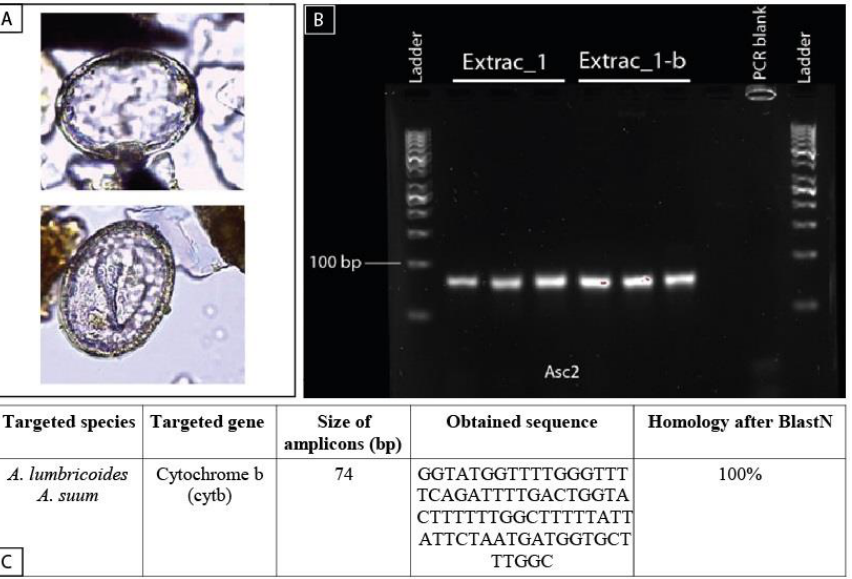
Figure 3. ( A ) Ascarid-type eggs corresponding to decorticated “ Ascaris eggs” observed under the Uffizi Gallery in Florence, 62 µm × 47 µm each, 400×. ( B ) Visualization on electrophoresis gel (2%) of obtained amplicons from 6 PCRs reactions in 2 sediment DNA extractions showing a clear positive reaction for the targeted taxon ( Ascaris sp.). ( C ) Targeted gene for Ascaris sp. DNA amplifica- tion and obtained sequence. The 74 bp long fragment showed 100% homology with the currently known Ascaris sp. genome when blasted in Genbank.